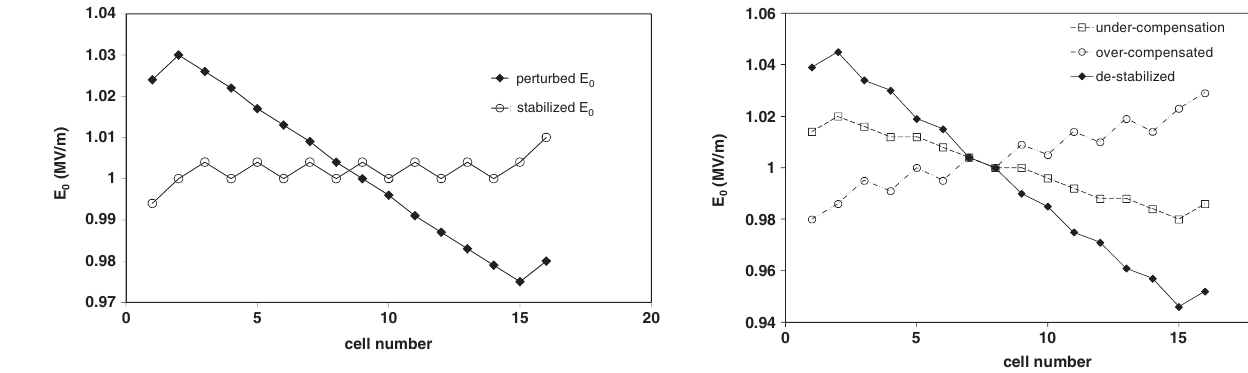
FIG. 16. Perturbed E without PCs and with PCs at stabilizing 0 from a circuit simulation. E is here normalized to 1, value of C p 0 with respect to the nominal value.